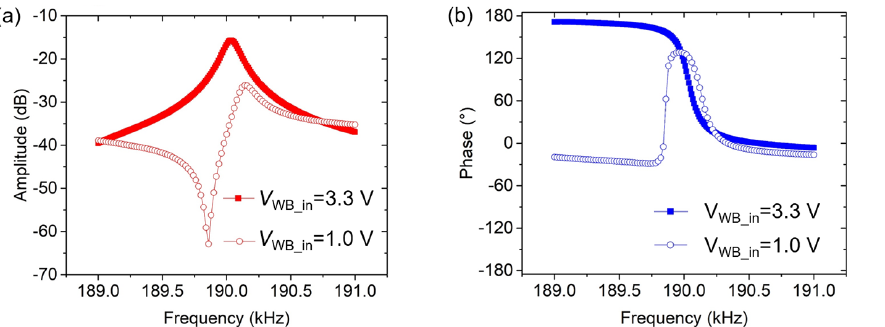
Figure 4. Measured (a) amplitude (red) and (b) phase characteristics (blue) of a thermally actuated cantilever sensor at different WB input voltages: V WB_in = 1V (open line), V WB_in = 3 . 3V (solid line).